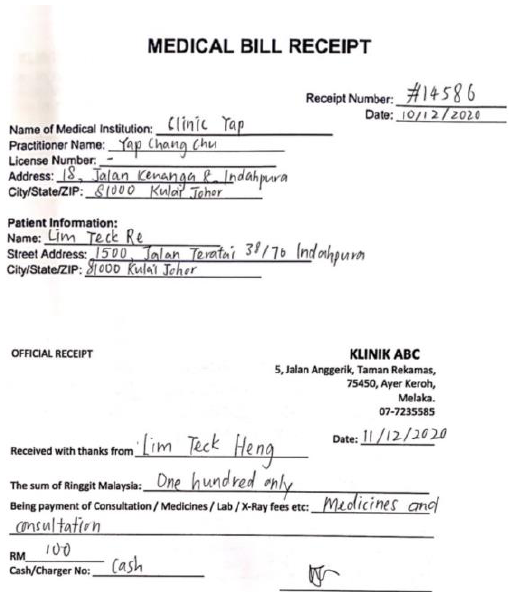
Figure 1. Samples of collected handwritten clinical